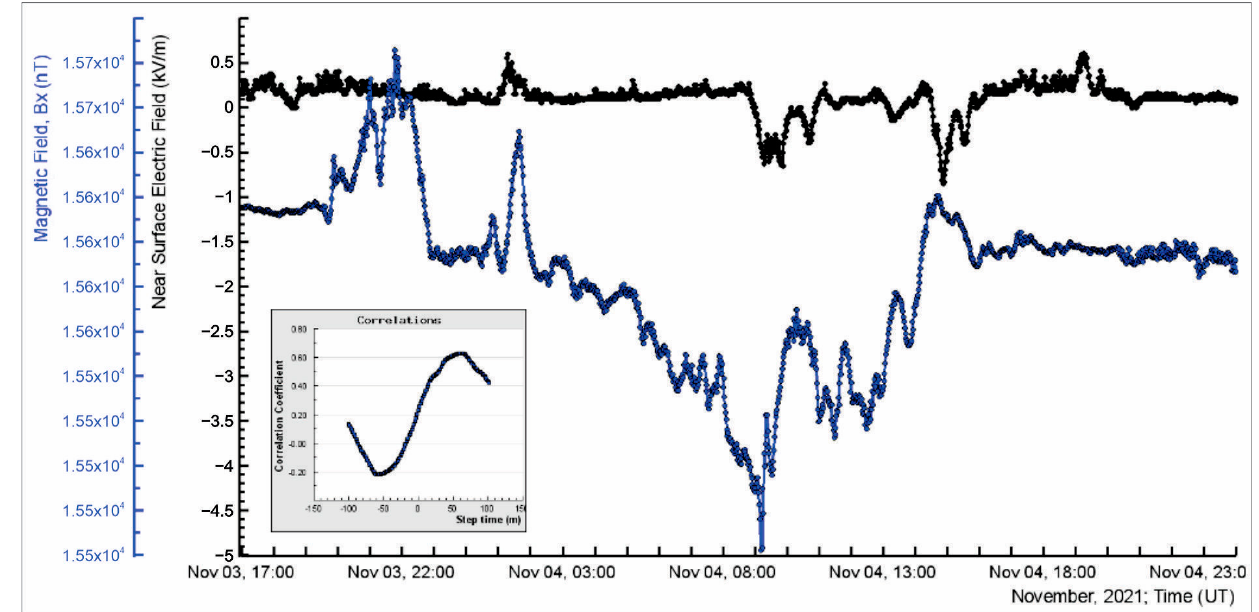
Figure 18. Disturbances in the X-component of the geomagnetic field (blue) and NSEF (black) during the FD. The inset shows a curve of lagged correlations; NSEF disturbances lag relative to geomagnetic field disturbances by ≈ 50 min.